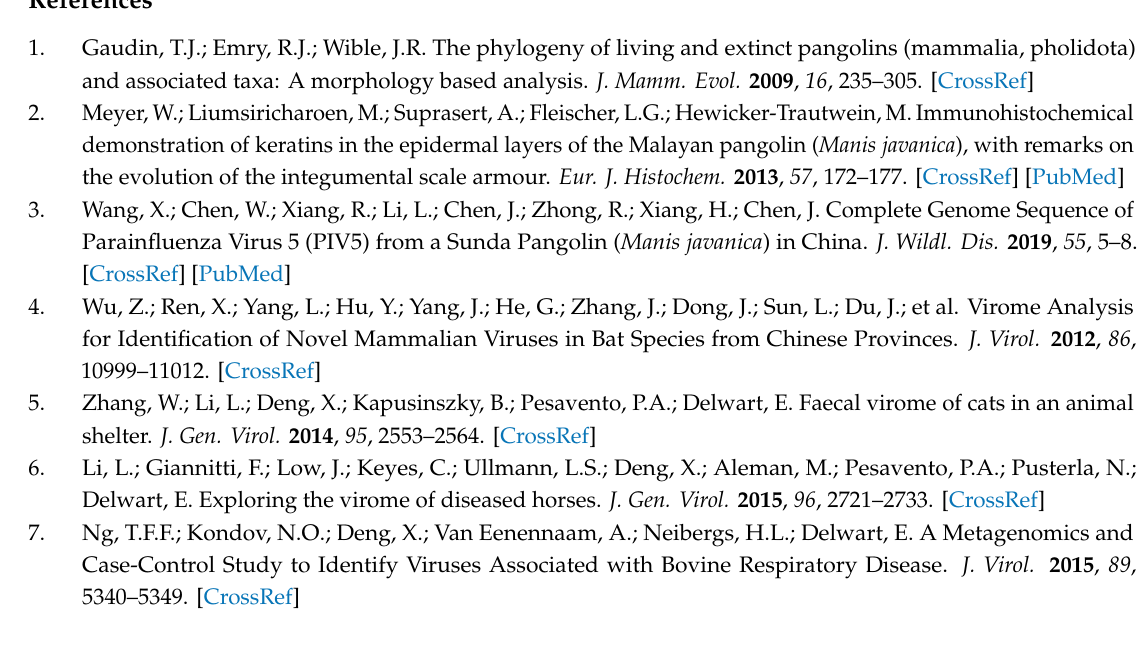
Figure S1: Length distribution of all the unique contigs generated by de novo assembly. The horizontal axis indicates length of contigs, while the vertical axis indicates number of contigs at di ff erent stages of length, Table S1: Number of sequencing reads assigned to di ff erent virus families in each Malayan pangolin sample, Table S2: Information of contigs with moderate level of sequence similarity to known viruses. Query ID: query sequence ID; Subject ID: the target sequence ID; identity (%): the percentage of consistency of sequence alignment; Alignment Length: the length of the matched area; Mismatches: the number of mismatch bases in the matched area; Gap Openings: the number of gaps in the matched area; q Start: the starting point of the comparison region on the query sequence; q End: the termination point of the matched area on the query sequence; s Start: the starting position of the matching region on the subject sequence; s End: the termination site of the matched area on the subject sequence; e-Value: the expected value of the comparison result; Bit Score: the bit score value of the comparison result; Taxonomy: Annotation